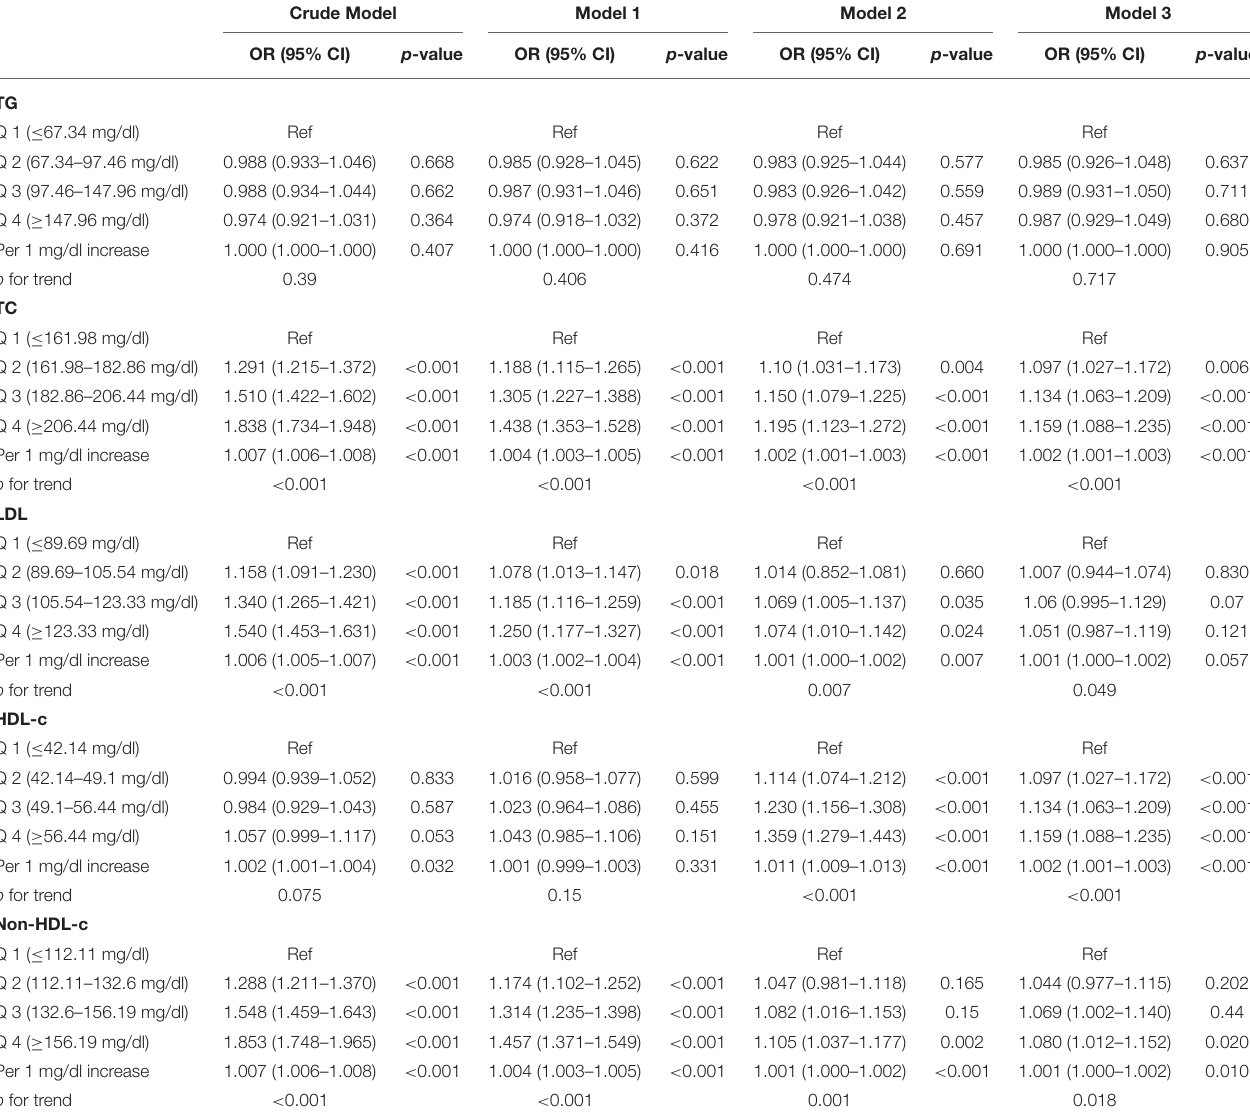
TABLE 3 | Multivariable logistic regression model evaluating the association between lipid levels and hypertension